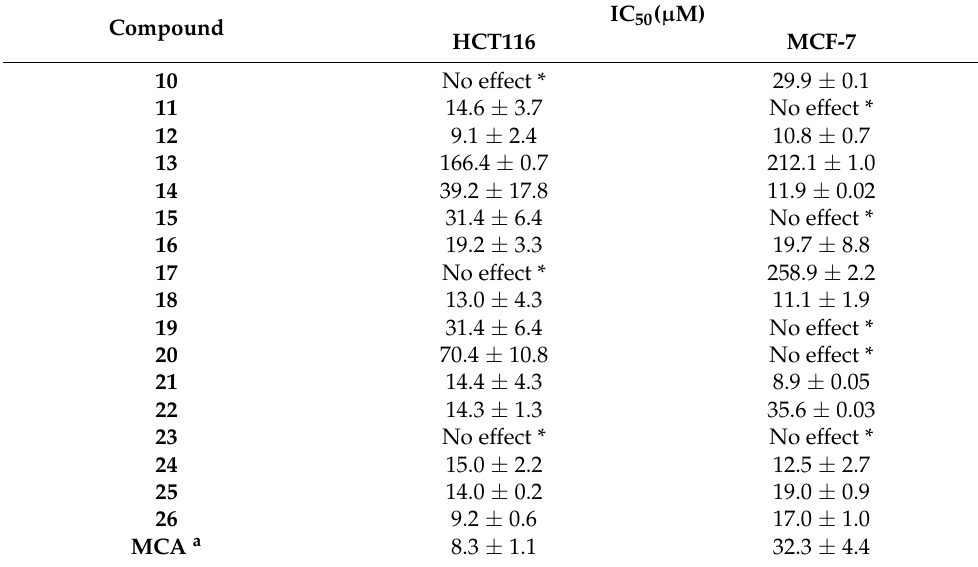
Table 2. IC 50 calculated for HCT116, and MCF-7 cell lines after 72 h of incubation with tested compounds (mean value from 3 experiments ±